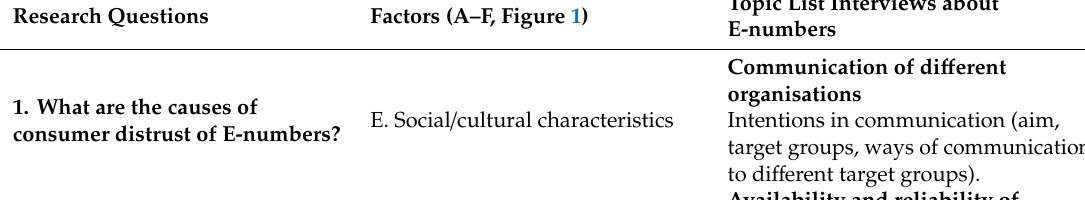
E ff ect: objective e ff ects, scientific proven